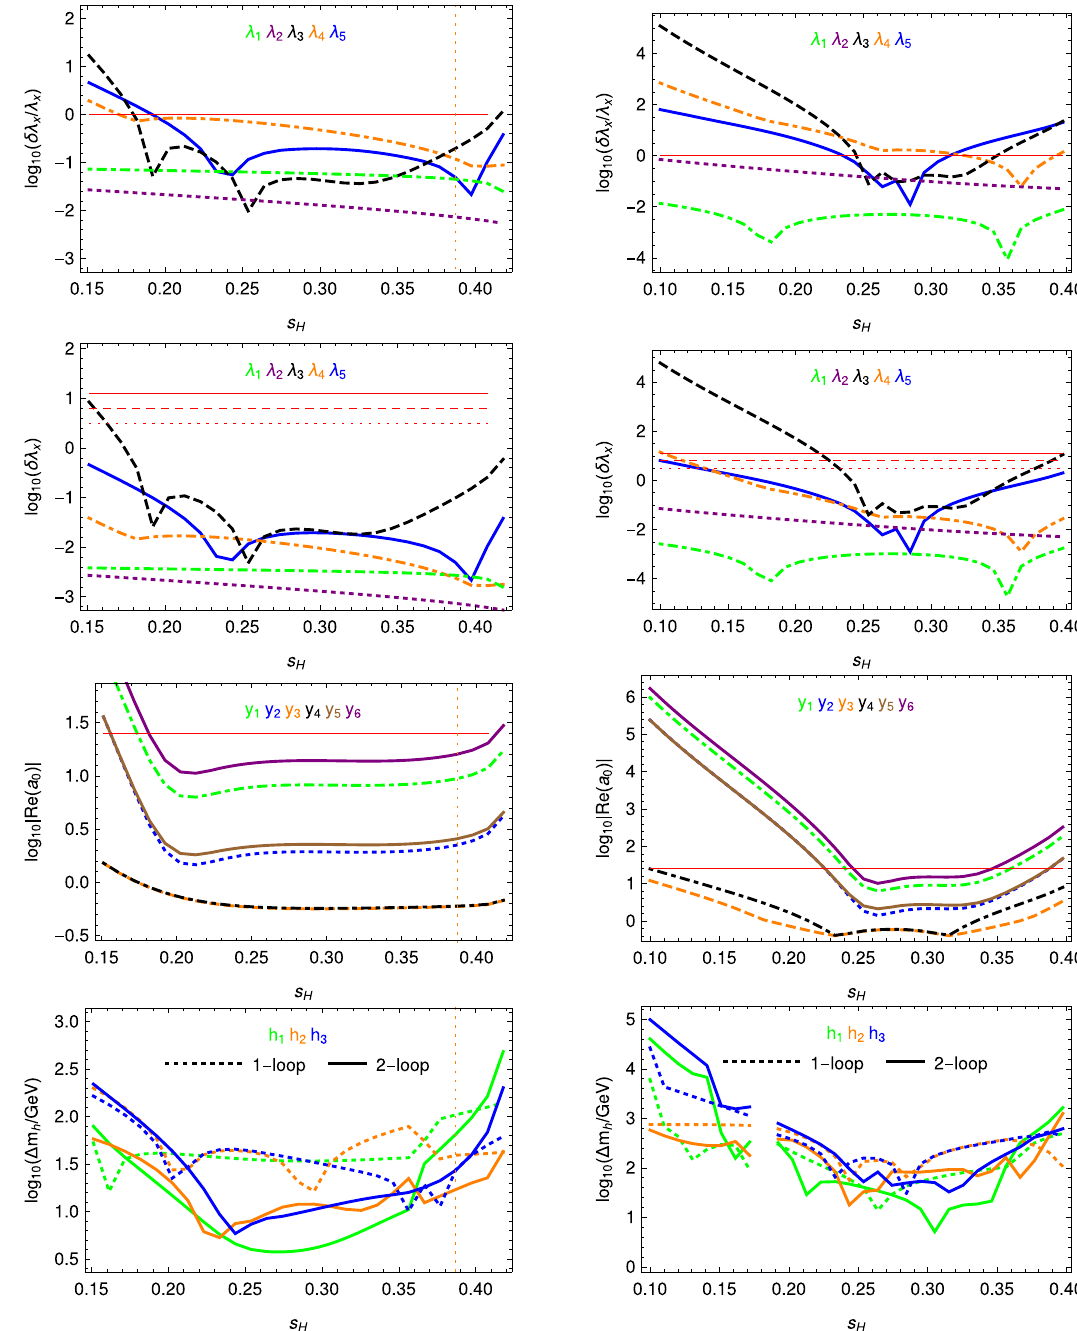
scalar masses in the MS scheme. The red line in the second row indi- cates values of π , 2 π and 4 π and in the third row of 8 π . On the left we set m H = 300 GeV, on the right m H = 800 GeV. The other parameters are analogous to Fig. 2